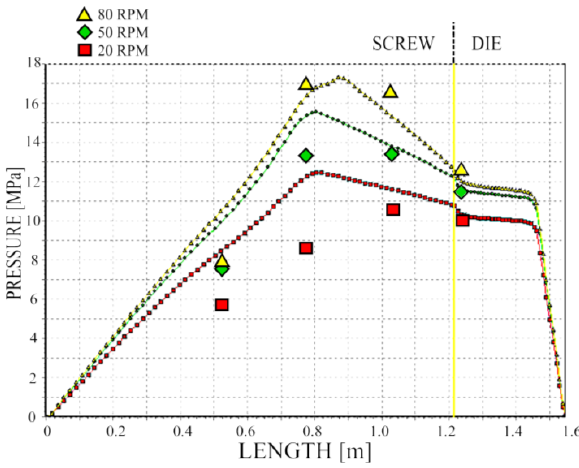
Figure 14. Validation of pressure computation.